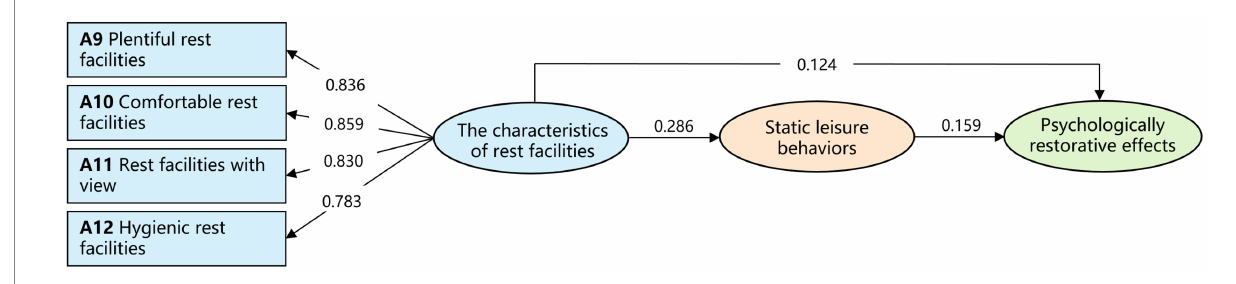
FIGURE 9 Influence effect illustration of the characteristics of rest facilities.